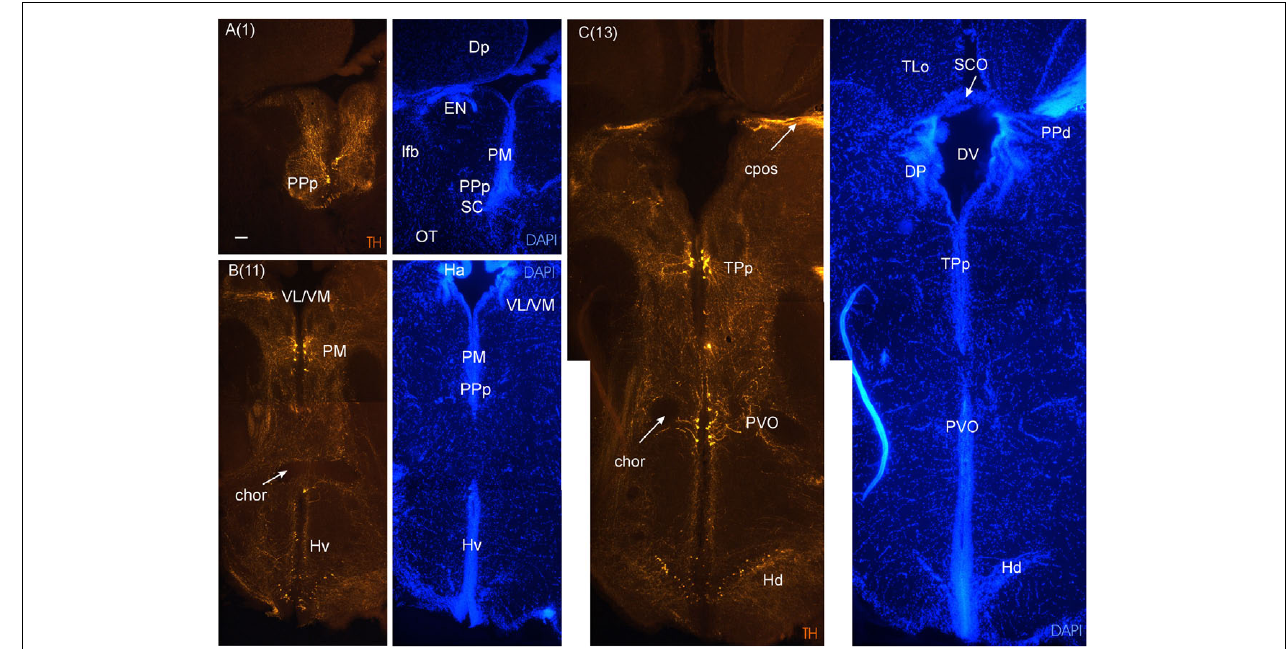
FIGURE 5 | Consecutive transverse sections of the archerfish diencephalon immunostained for tyrosine hydroxylase (TH) with accompanying nuclear (DAPI) counterstain. Dopamine cells start out anteriorly in preoptic nuclei (PPp, PM seen in A ), and are present more caudally in the ventral thalamus (VL/VM seen in B ) and in the posterior tuberculum (TPp, PVO seen in C ). In the hypothalamus, dopamine cells are present in the ventral and dorsal periventricular zones (Hv and Hd seen in B and C ). Arabic numerals in brackets indicate the relative distance of sections. Scale bar in (A) : 0.1 mm (applies to all panels). See abbreviation list and text for